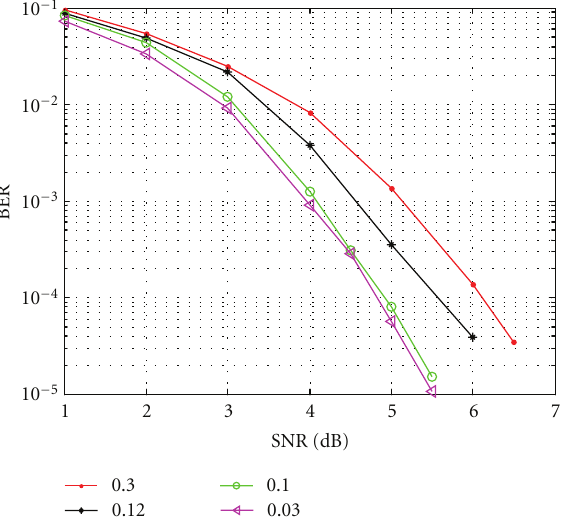
Figure 6: E ff ect of code length on DDGA performances.